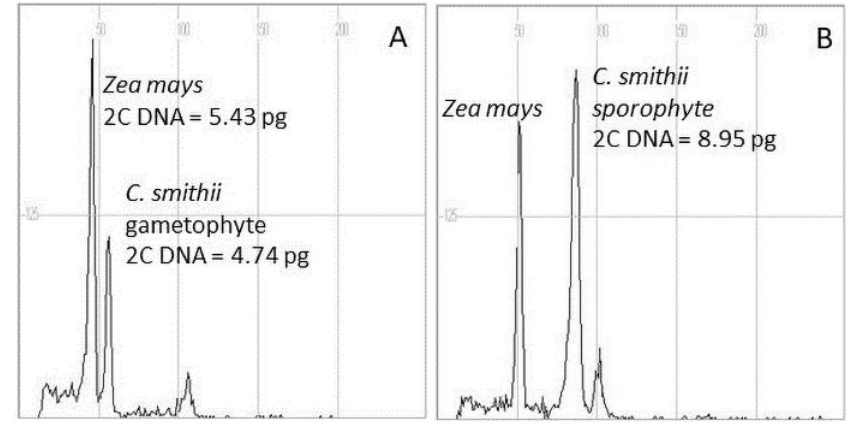
Figure 6 Flow cytometric analysis of nuclear DNA content of regenerants of Cyathea smithii using young leaves of maize ( Zea mays L.) CE-777 2C DNA = 5.43 pg (Lysak & Doležel, 1998) as internal standards. ( A ) G ametophyte and ( B )